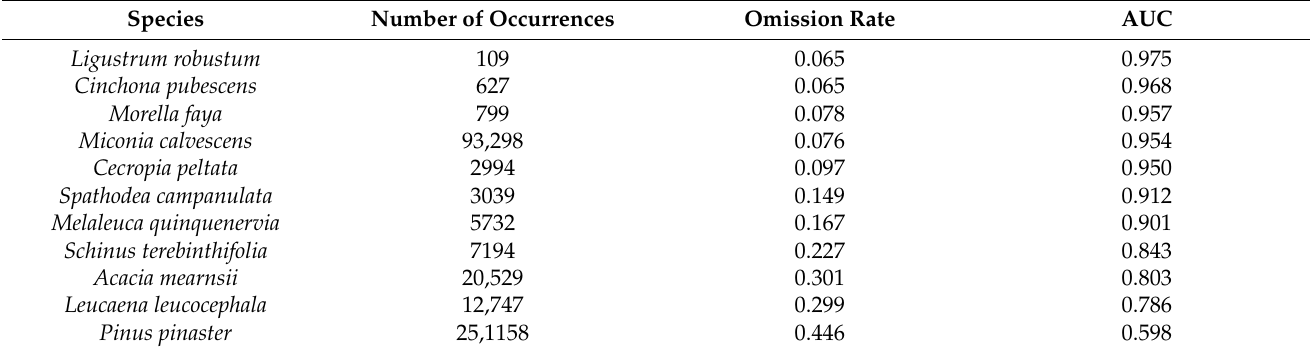
Table 1. Area under the curve (AUC) and omission rate values for 11 invasive tree